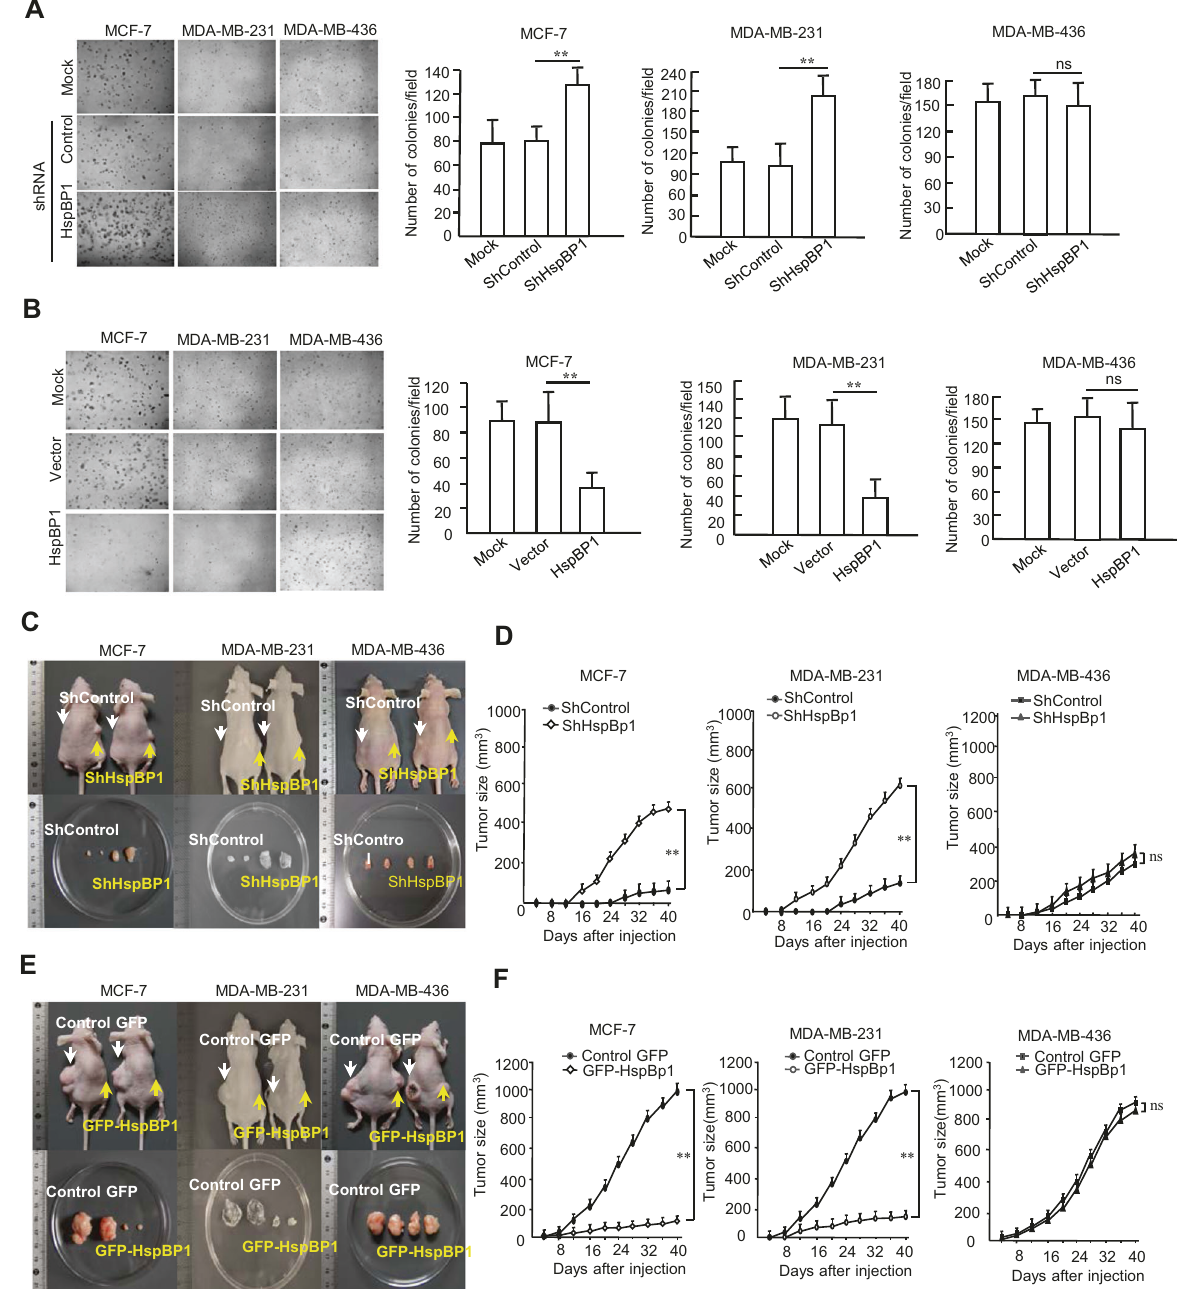
Fig. 1 HspBP1 inhibits tumor growth of BRCA1-pro fi cient breast cancer cells. A Anchorage-independent colony formation in soft agar of control and HspBP1-depleted BRCA1-pro fi cient (MCF-7, MDA-MB-231) and BRCA1-de fi cient (MDA-MB-436) cells. Data represent the average cell number from 5 viewing fi elds and are shown as mean ± SD. ** P < 0.01. ns, not signi fi cant, two-tailed Student ’ s t -test. B Anchorage- independent colony formation in soft agar of control and HspBP1-overexpressing MCF-7, MDA-MB-231 and MDA-MB-436 cells. Data represent the average cell number from 5 viewing fi elds and are shown as mean ± SD ( n = 3). ** P < 0.01. ns Not signi fi cant, two-tailed Student ’ s t -test. C, D Same cells described in ( A ) were injected into the left (control) and right fl ank of nude mice ( n = 6). Photographs of representative mice and tumors ( C ) and growth curves of mammary tumors after implantation ( D ) are shown. Data are mean ± SD ( n = 3). ** P < 0.01. ns Not signi fi cant, two-way ANOVA. E, F Same cells described in ( B ) were inoculated subcutaneously into nude mice. Photographs of representative mice and tumors ( E ) and growth curves of mammary tumors after implantation ( F ) are shown. Data are shown as mean ± SD ( n = 3). ** P < 0.01. ns Not signi fi cant, two-way ANOVA. HspBP1 is recruited to sites of DNA damage and interacts with control cells (Fig. 2D, E). Taken together, these data suggest that BRCA1 the HspBP1 contributes to BRCA1 phosphorylation and recruit- To elucidate the molecular mechanisms by which HspBP1 affects ment to sites of DNA damage in response to treatment with BRCA1 functioning, we fi rst looked for direct interactions between irradiation.